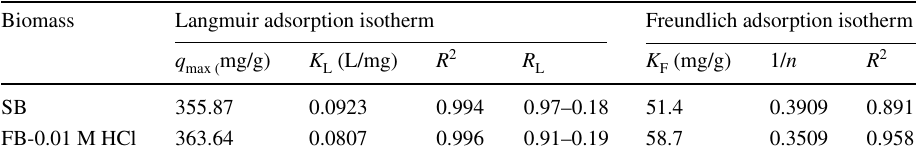
Table 2 Adsorption isotherm parameters